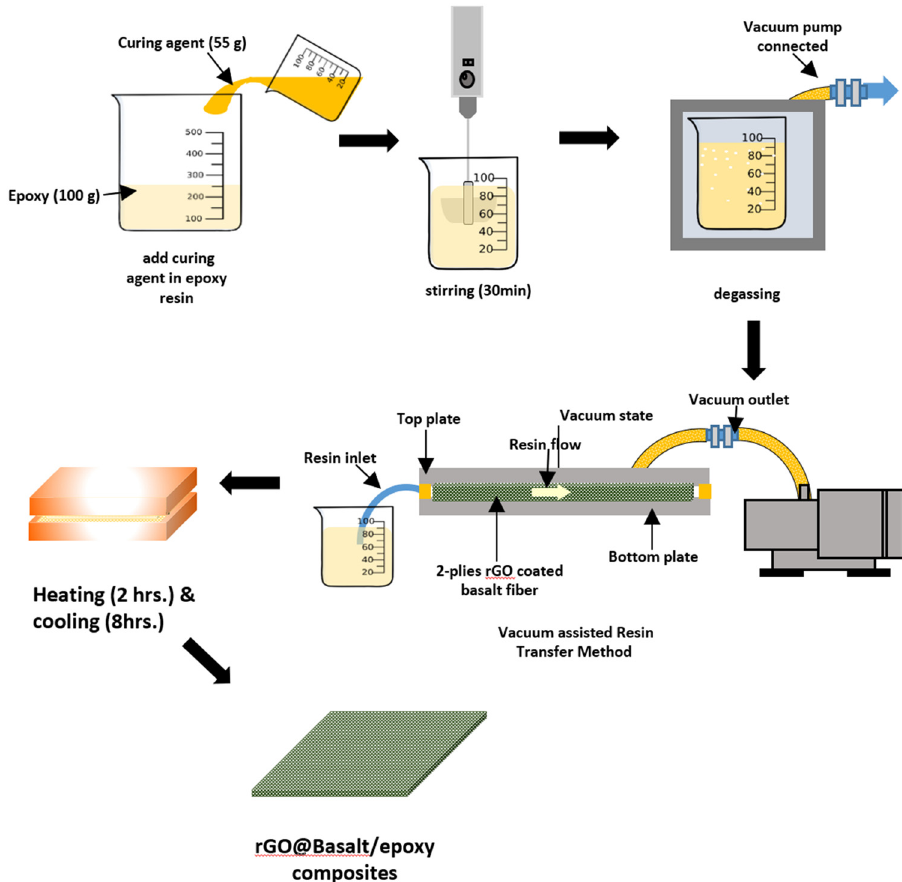
Figure 1: Schematic of the fabrication of rGO@Basalt/epoxy composites using the VaRTM method.